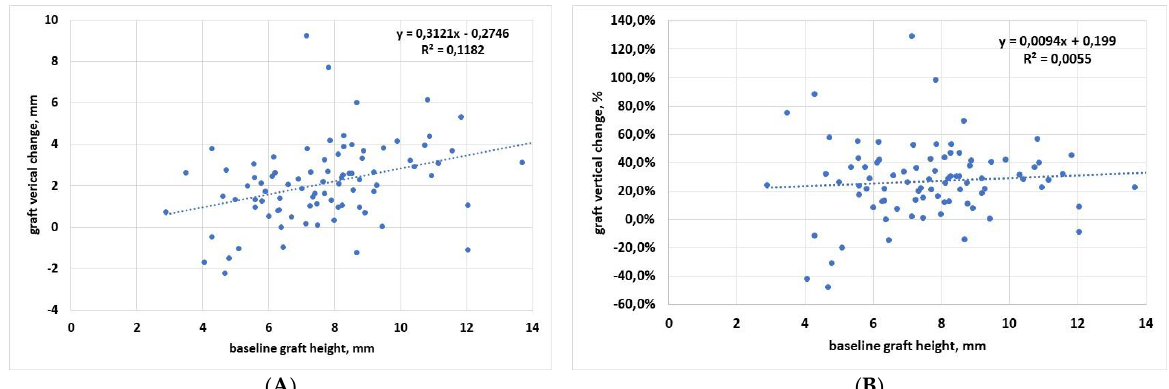
Figure 2. Regression analysis for vertical dimension change with respect to baseline. ( A ) Data in mm; ( B ) data in percentage.